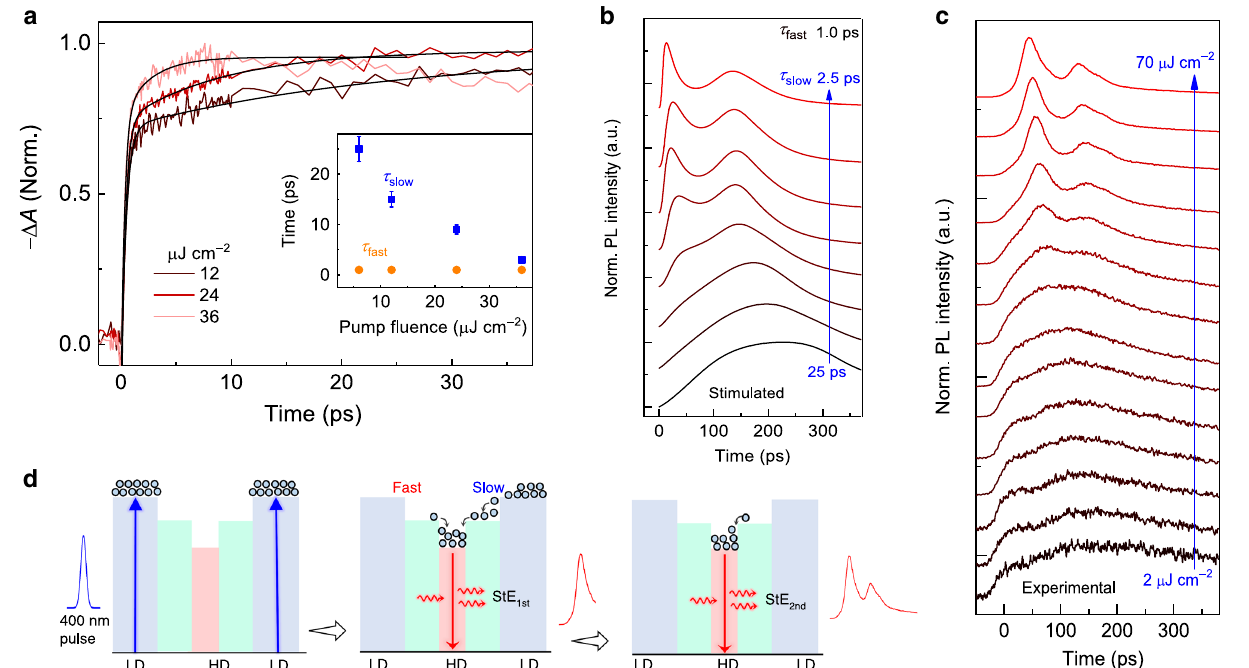
Fig. 3 Origin of the ultrashort laser pulse doubling. a Normalized transient absorption (TA) dynamics probed at the excitonic photobleaching peak (at 750 nm) of the high-dimensional (HD, n ≥ 5) perovskite QWs in the gain medium. Inset shows the fi tted TA peak rising time as a function of pump fl uence. The error bars represent the uncertainties of the fi ttings. b Simulated carrier recombination dynamics at different carrier funneling times and recombination rates in the perovskite MQWs gain medium. See Supplementary Note 1 and Supplementary Table 1 for detailed parameter values. c Normalized time- resolved photoluminescence (TRPL) decay curves for perovskite MQWs from low to high pump fl uence following excitation at 400 nm (1 kHz, 50 fs). d Schematic illustration of the formation of double-pulsed stimulated emission (StE) by single fs laser pulse pumping via the fast and slow carrier funneling processes in